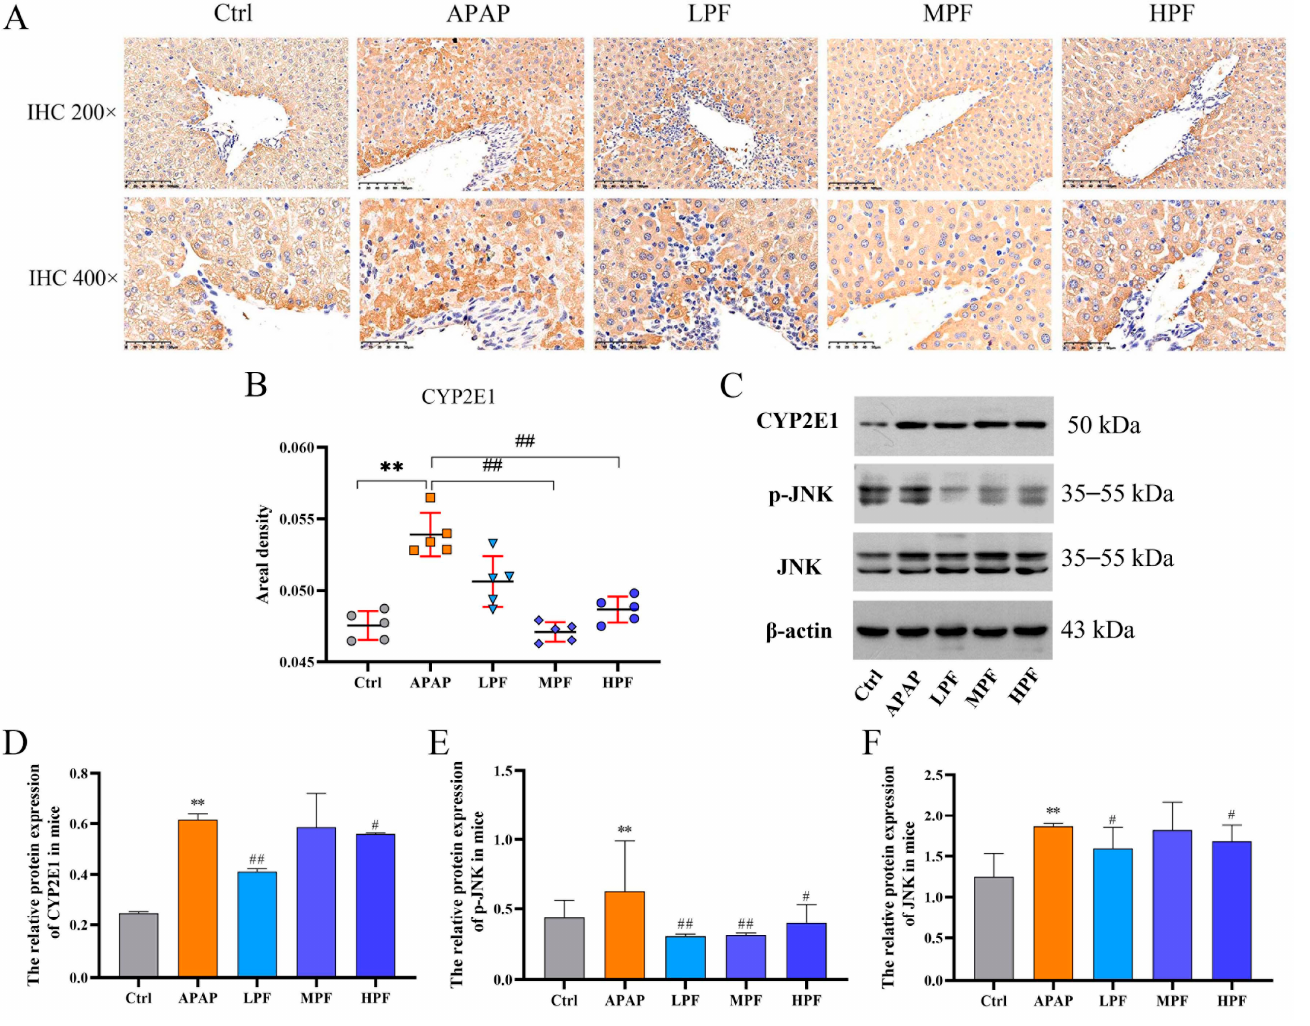
Figure 5. Effects of PF on the expression of CYP2E1/JNK signaling. ( A ) Immunohistochemical analysis of CYP2E1. ( B ) The areal density of CYP2E1. ( C ) The Western blotting images of CYP2E1, p-JNK, and JNK in mice. ( D ) The relative protein expression of CYP2E1 in mice. ( E ) The relative protein expression of p-JNK in mice. ( F ) The relative protein expression of JNK in mice. All data were presented as mean ± SD. ** p < 0.01, compared with control group; # p < 0.05, ## p < 0.01, compared with APAP group.